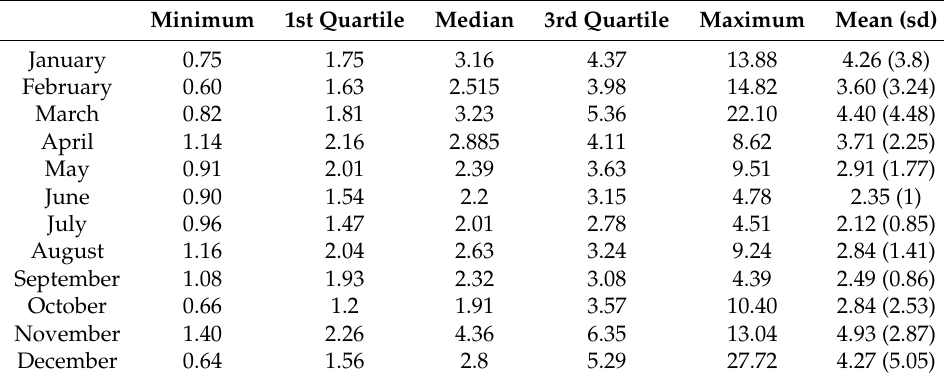
Table 12. Monthly MAPE (%) for model